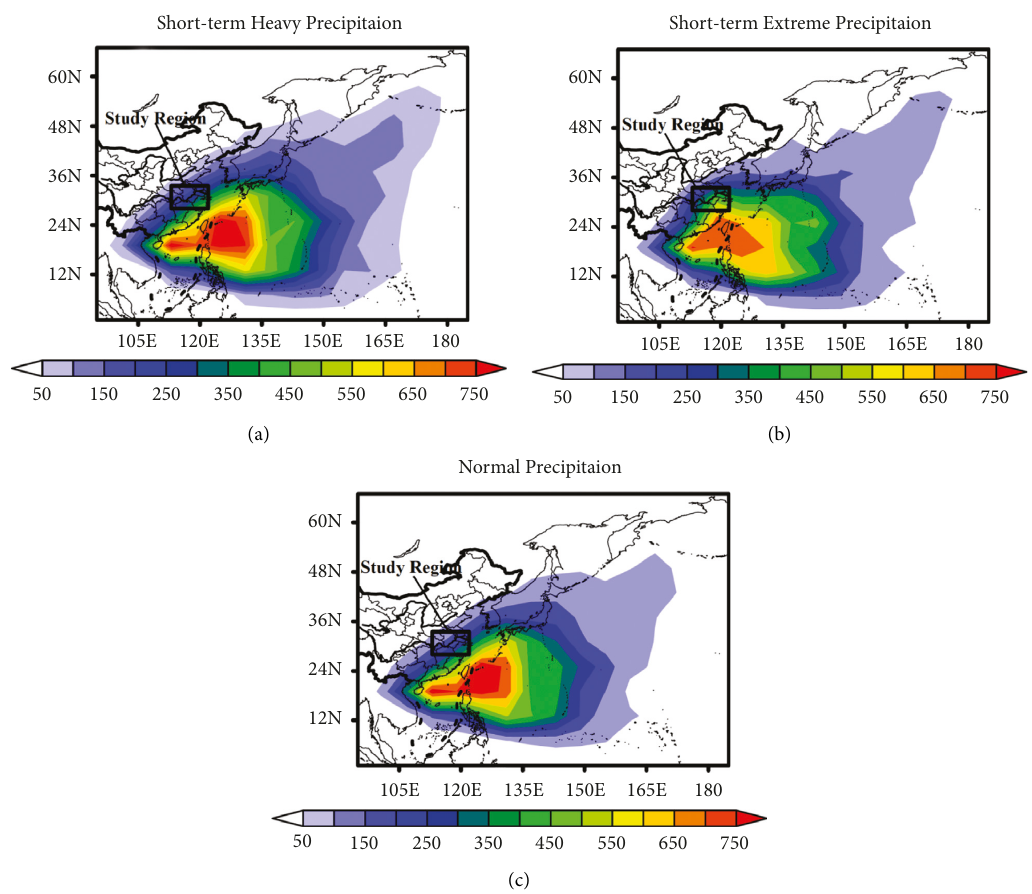
Figure 6: Spatial distribution of the frequency of typhoon tracks corresponding to the occurrence of different precipitation